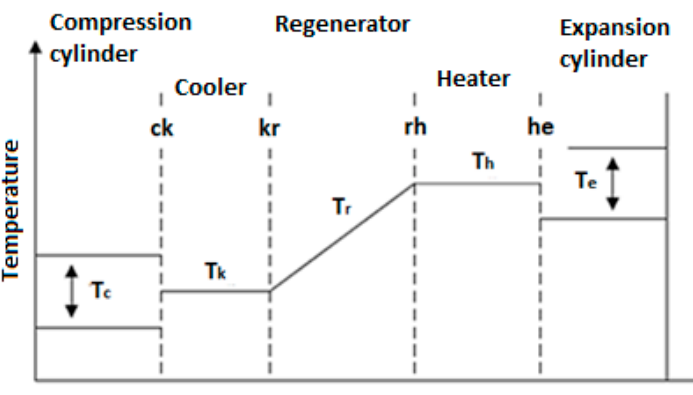
Figure 4. Temperature change in control volumes, adapted from [17].